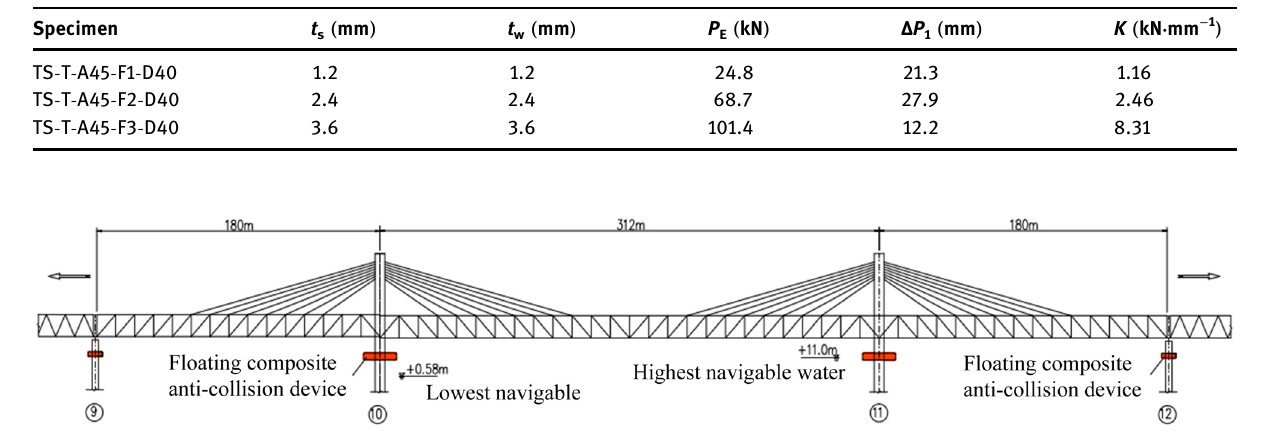
Figure 19: Wuhu Yangtze River Bridge.